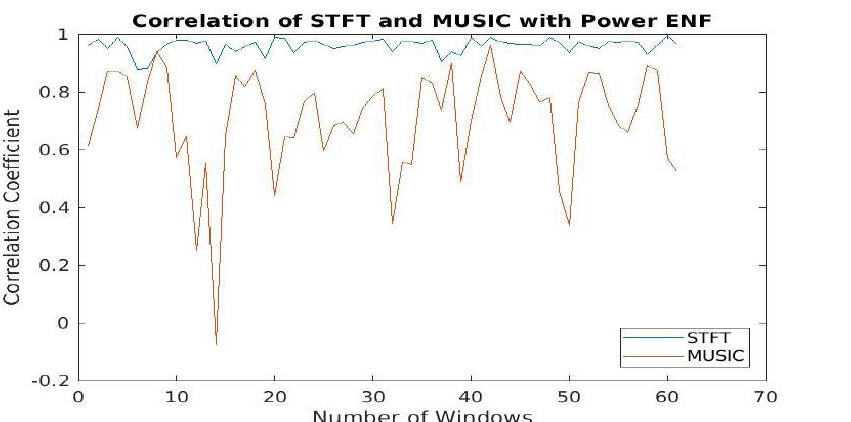
Figure 4. Spectrum estimation techniques for ENF estimation in a video recording with a moving subject under artificial